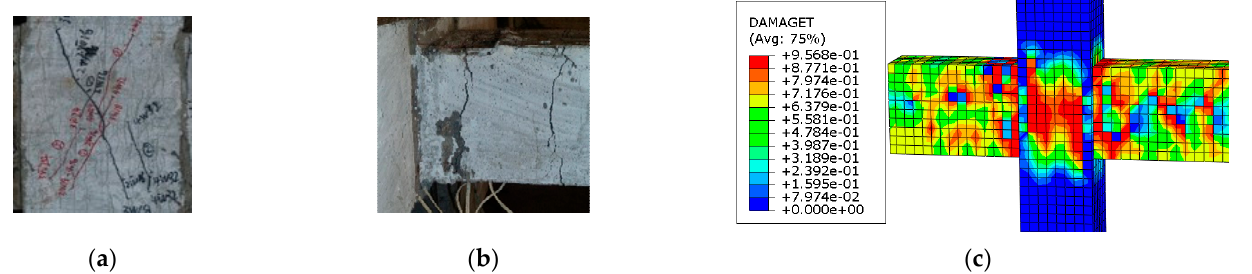
Figure 7. Failure model of BCJ1 specimen: ( a ) in the core joint of test; ( b ) in the beam of test; ( c ) in the FE analysis.